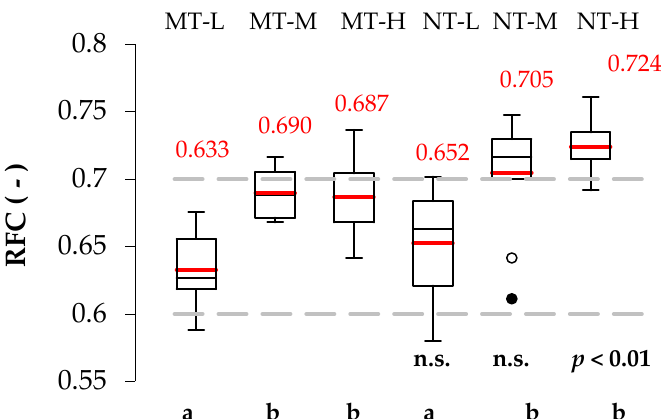
Figure 7. Box plots of relative field capacity ( RFC ). Intervals between the dashed lines represent the optimal values of RFC according to Reynolds et al. [16]. For a given soil management practice, mean values of water height followed by the same letter are not statistically different according to a Tukey HSD test; for a given water height, differences in soil management practices were reported according to a two-tailed t -test (n.s. = not significant). For the meaning of the abbreviations or interpret box plots, please refer to the caption of Figure 5.